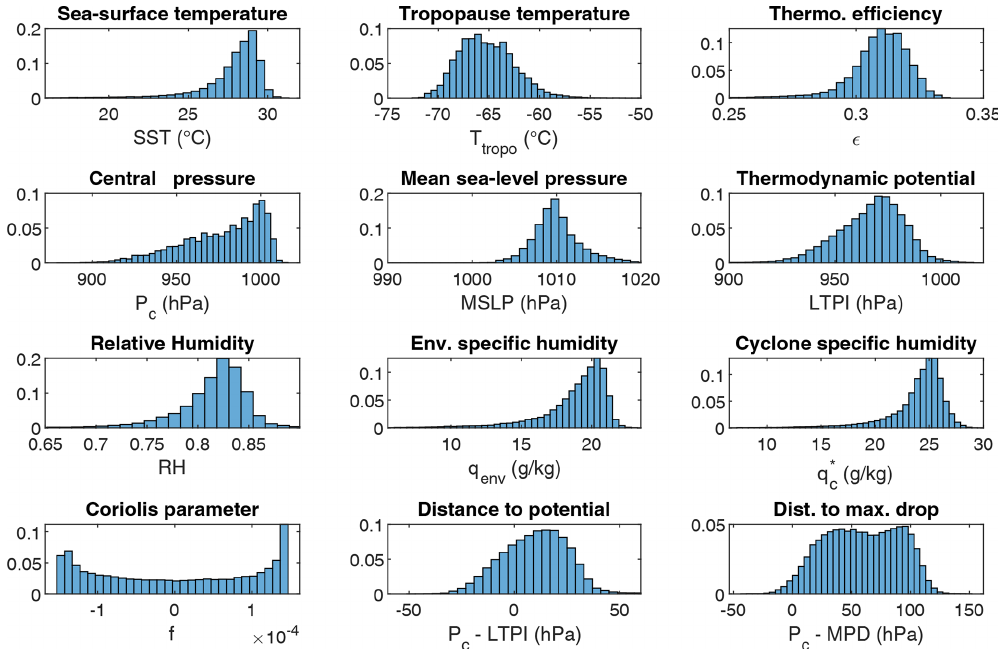
Figure 7. Empirical distribution of physical variables and CATHERINA instrumental variables computed from ERA5 along tracks in IB-